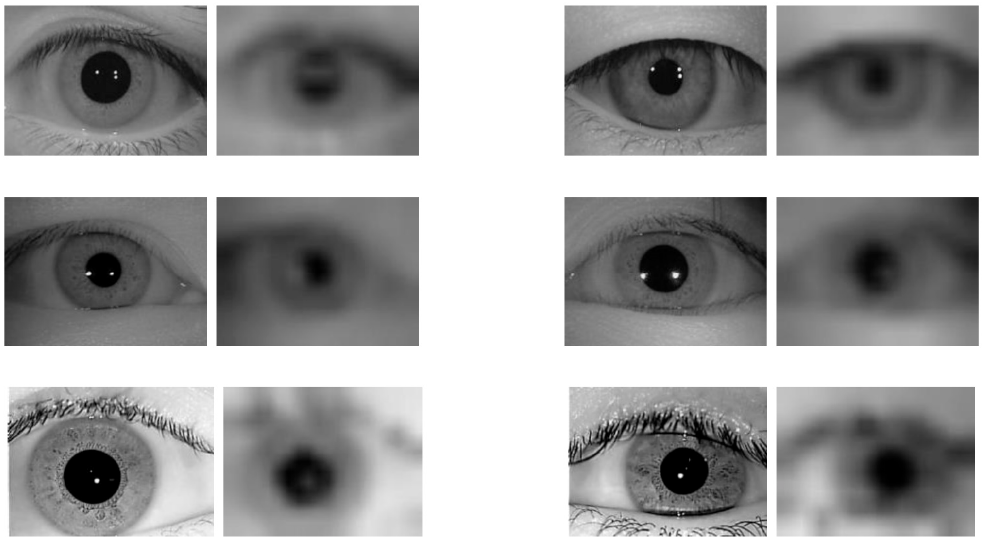
Figure 3. Examples of high- and low-resolution (1/16×) images. The first, second, and third rows are from the CASIA-iris-Lamp, Thousand, and IITD databases, respectively. Low-resolution images are reconstructed using traditional image processing or state- of-the-art deep learning using a database of high-resolution and low-resolution pairs. To noise ratio (SNR) [47], peak-signal-to-noise ratio (PSNR) [48], and structural similarity in-